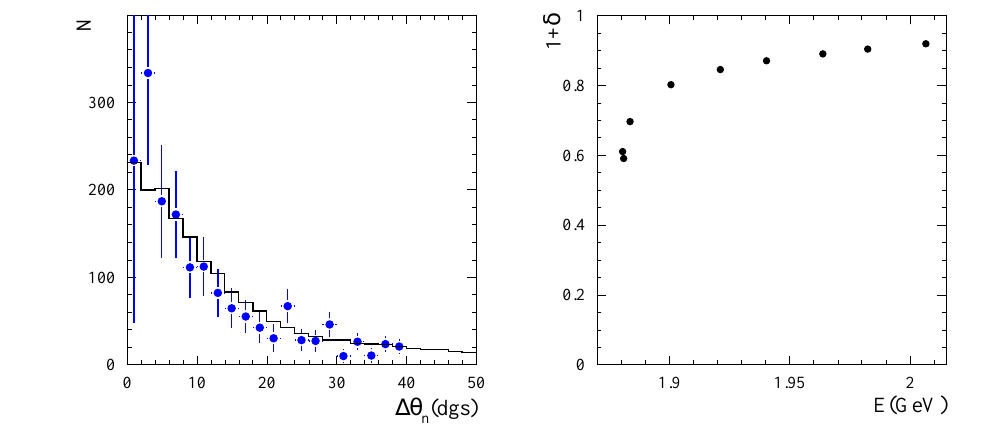
Figure 3. The distribution of the angle between the neutron-candidate direction and the reverse antineutron direction for data (points with error bars) and simulated (histogram) events.